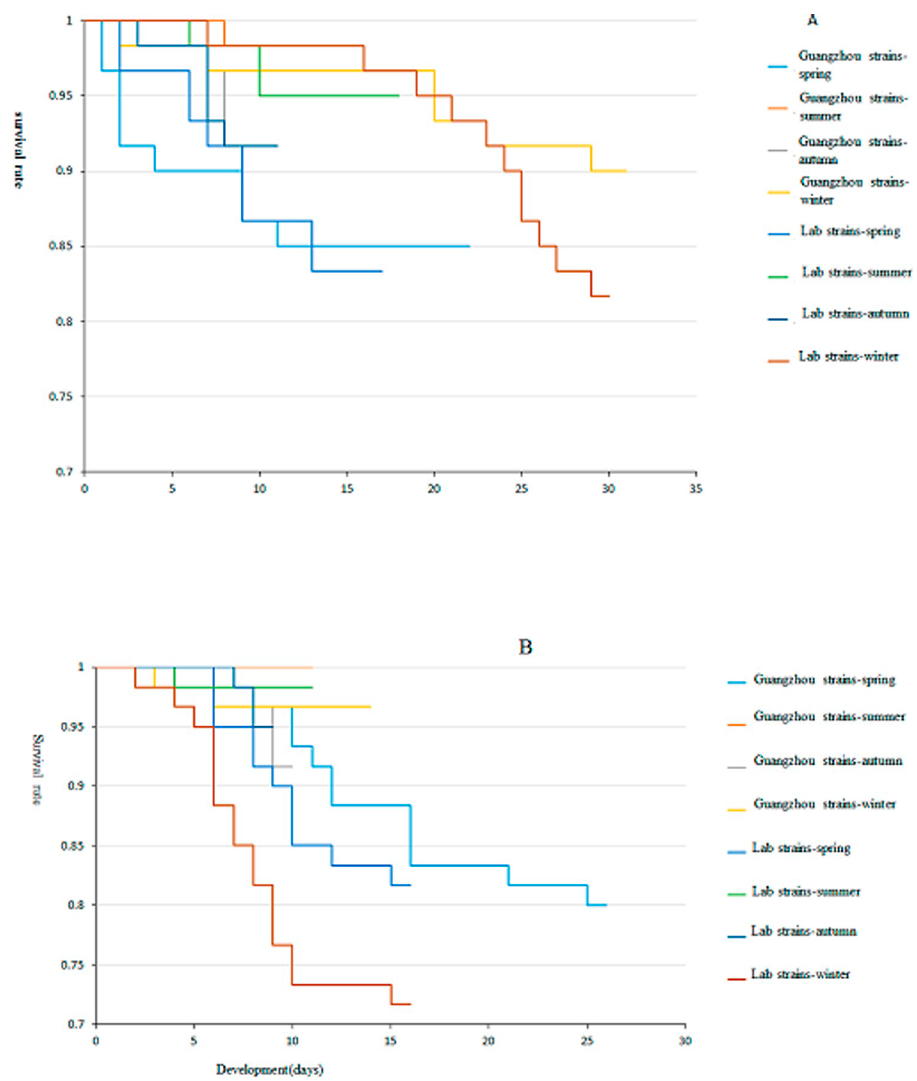
Fig 3. Kaplan–Meier survival curves of Ae . albopictus larvae in the wild environment (A) and laboratory environment (B).